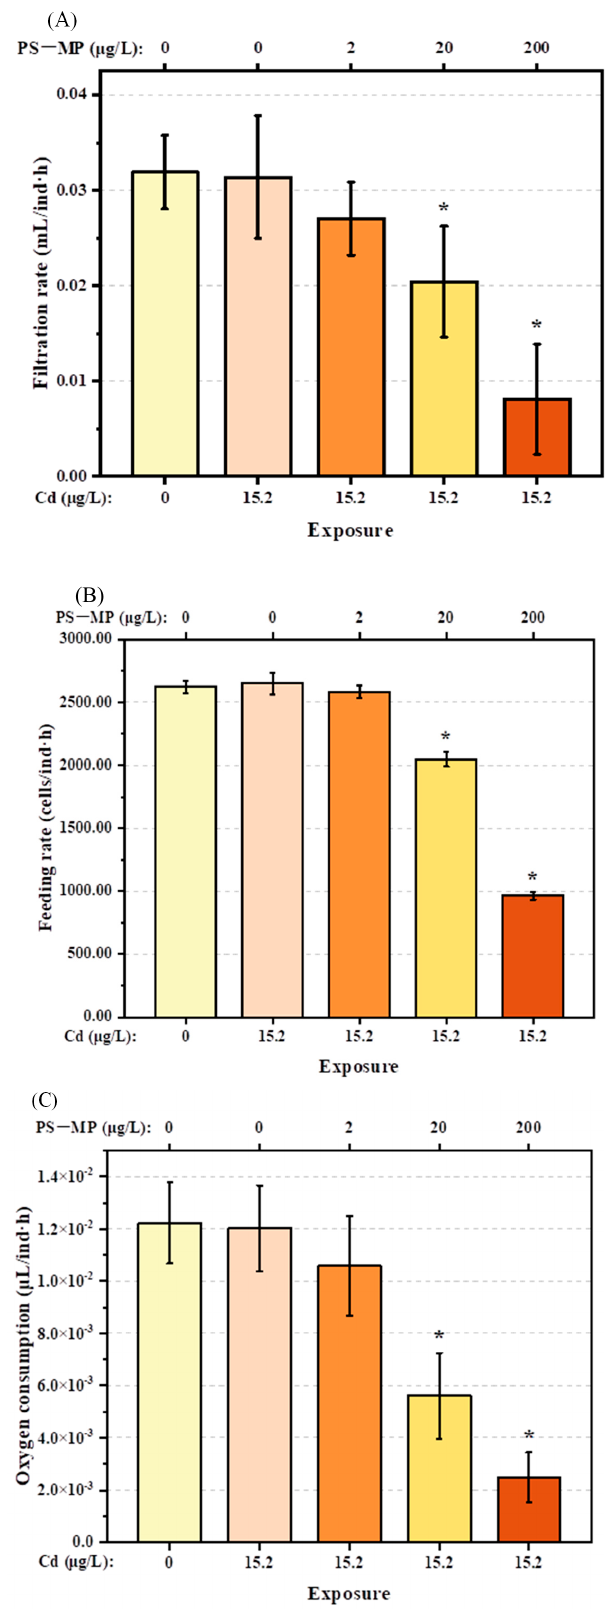
Figure 2. Physical activities of T. japonicas (F0 generation) exposure to Cd and PS-microplastic ( n = 5). ( A ) Filtration rate, ( B ) feeding rate, and ( C ) oxygen consumption. Significant differences between the exposure and control groups are marked with * ( p < 0.05).